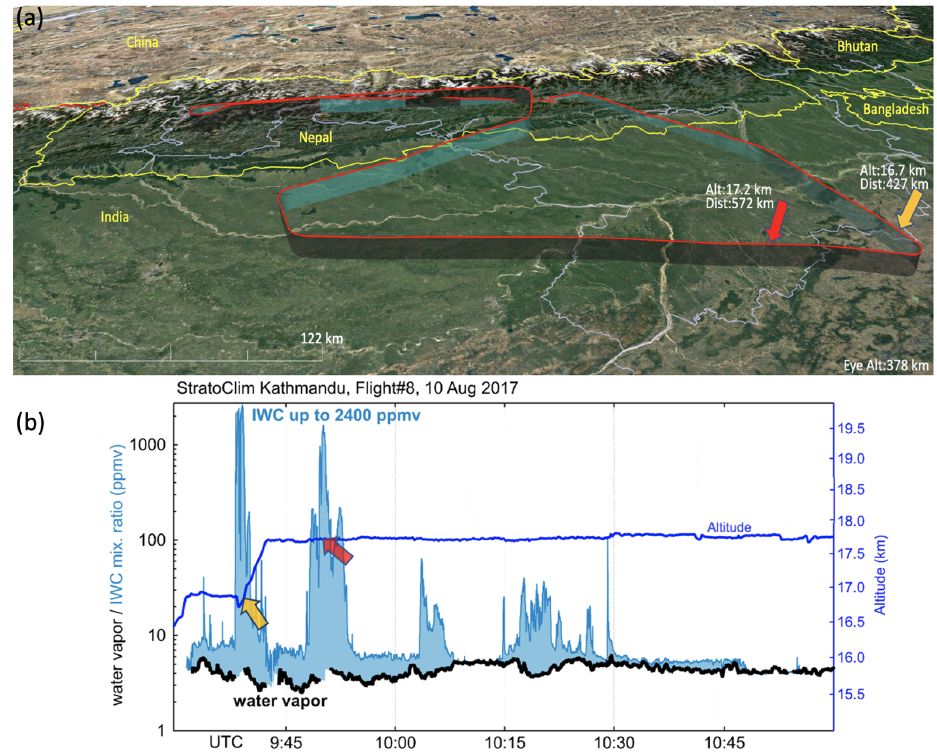
Figure 1. (a) Trajectory of Flight 8 and (b) the corresponding time series of water vapor (black), ice water content (light blue), and altitude (dark blue). Yellow and red arrows in both panels indicate the high ice water content’s peak location (a) and timing (b) . The corresponding altitude and distance from the point of origin are indicted near each arrow (a) . The map was made using © Google Earth 2022.